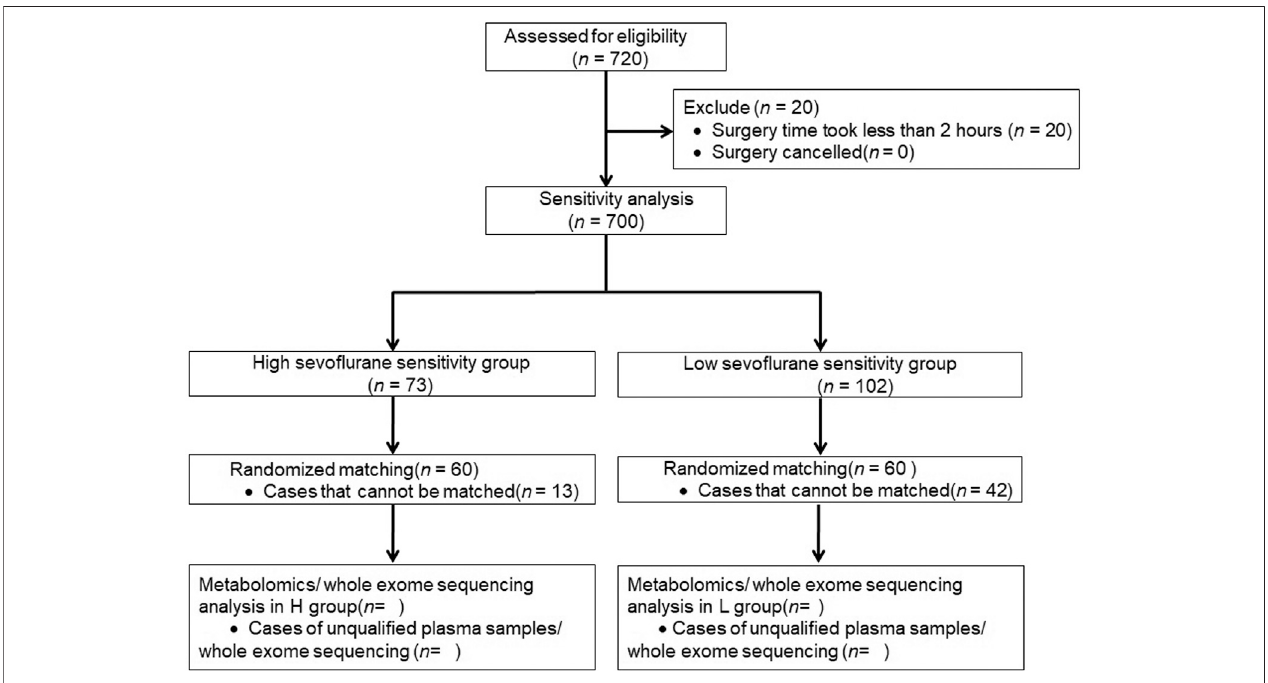
FIGURE 1 | Flow diagram of the